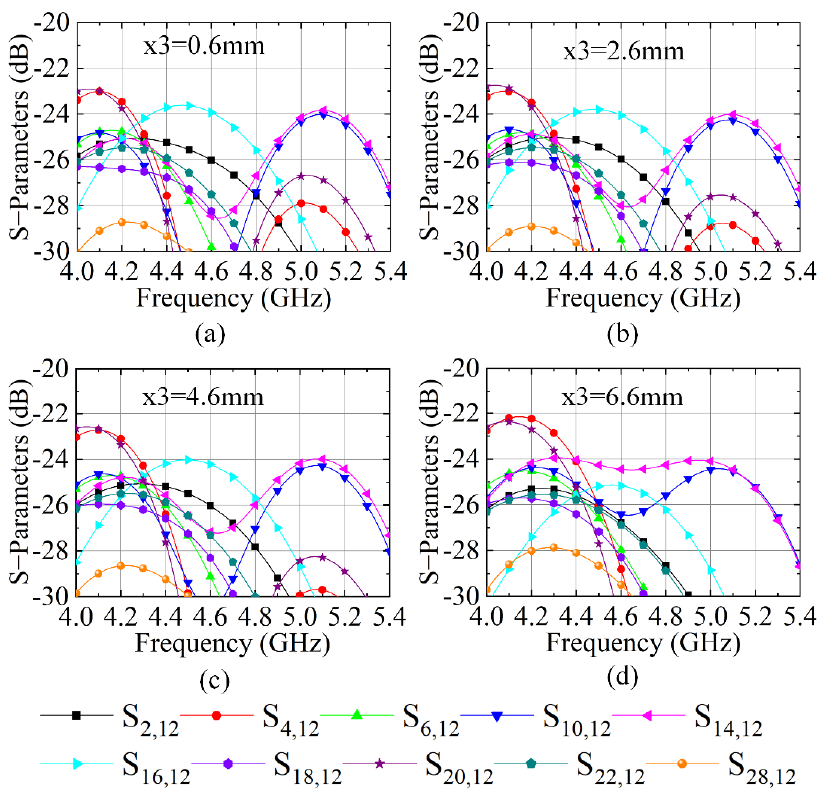
Figure 9. S-parameter of the antenna array loading with the proposed NRMS with different x3, ( a ) x3 = 0.6 mm, ( b ) x3 = 2.6 mm, ( c ) x3 = 4.6 mm, ( d ) x3 = 6.6 mm.